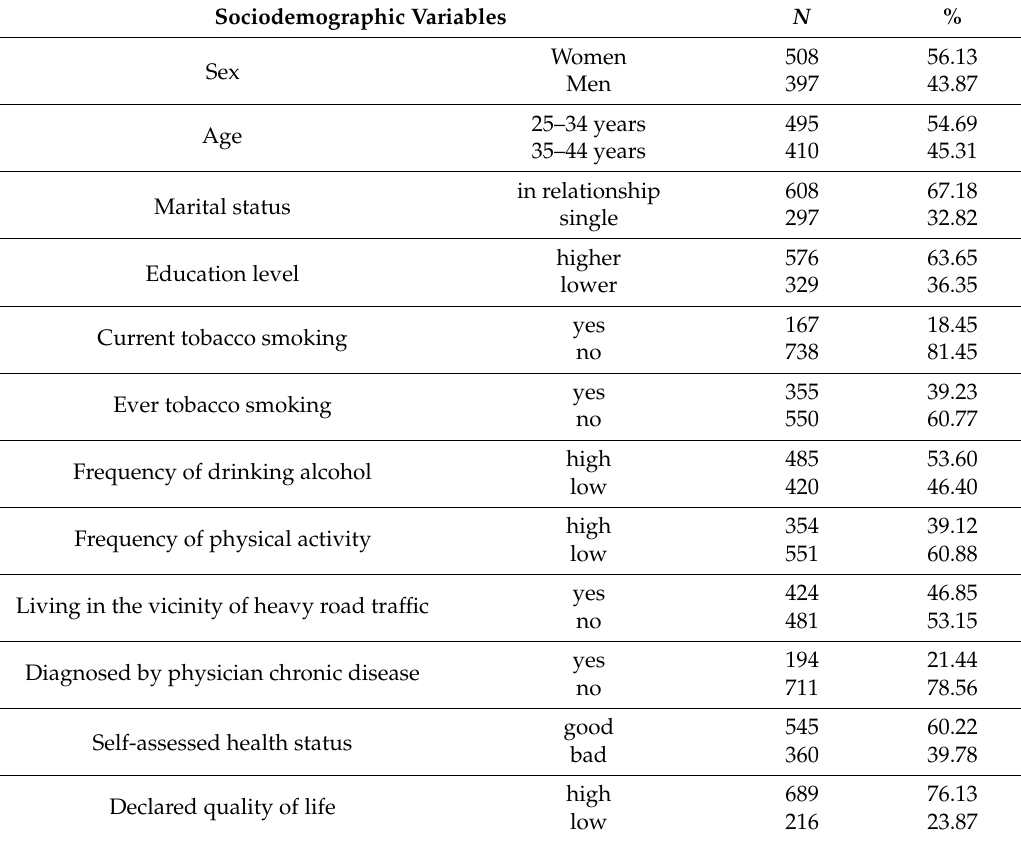
Table 2. Selected descriptive statistics for the study group ( N = 905).